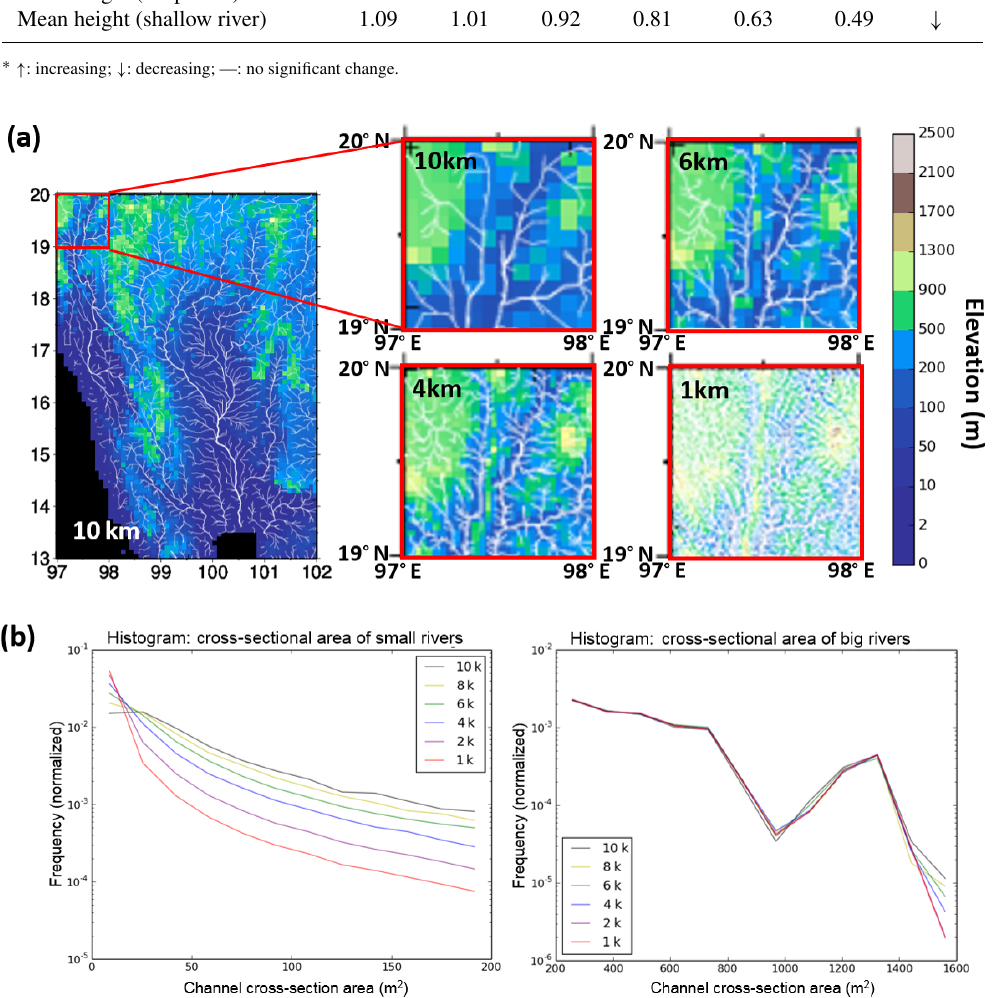
Figure 6. Impacts of increasing spatial resolution to the topographic and river channel characteristics in the model. (a) The elevation and subgrid representation of rivers (white lines) become increasingly detailed with finer spatial resolution. (b) The distribution of cross-sectional area of small (cross-section area < 200m 2 ) and big (cross-section area ≥ 200m 2 ) rivers in varying spatial resolutions; the distribution of small rivers significantly change with varying spatial